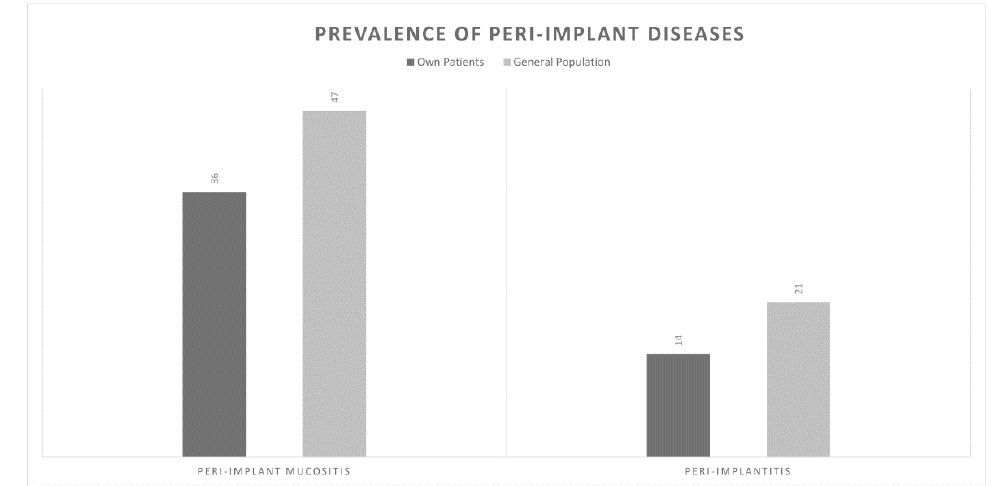
Figure 1. Estimated Prevalence of Peri-implant Diseases in the Australian population.